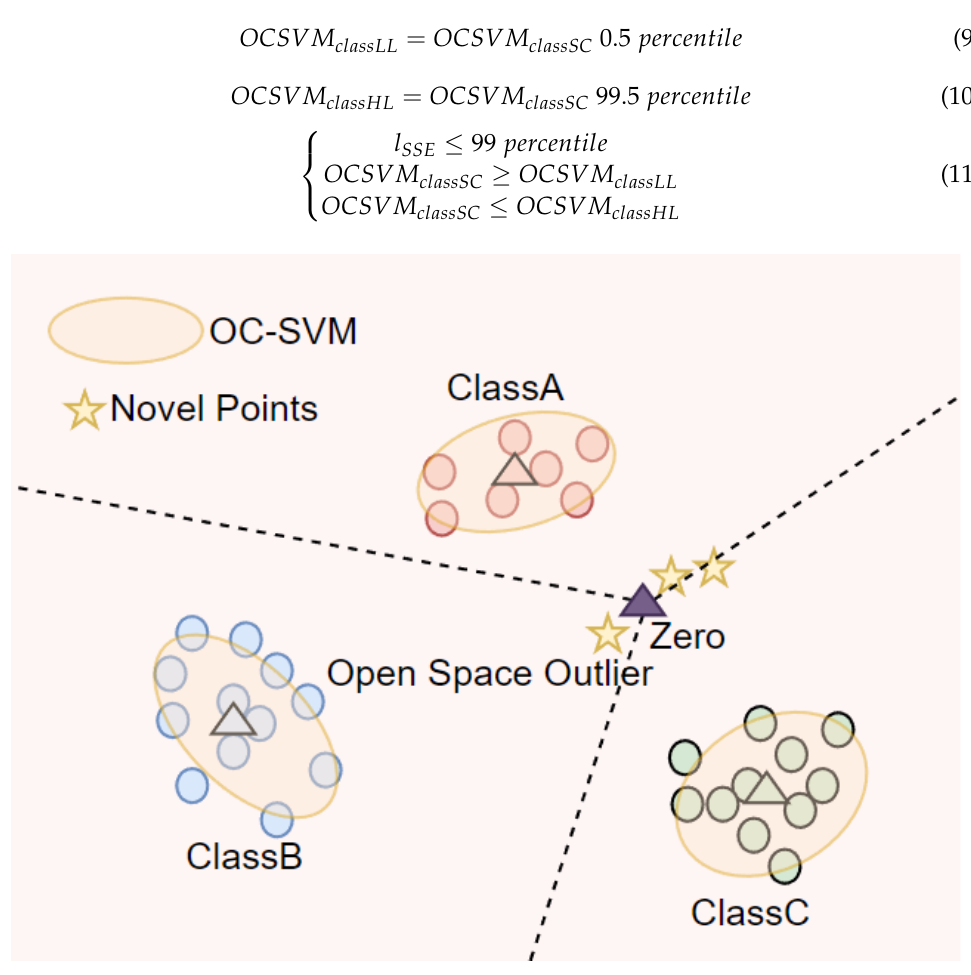
Figure 5. SLCPL feature space modeled by OC-SVM.